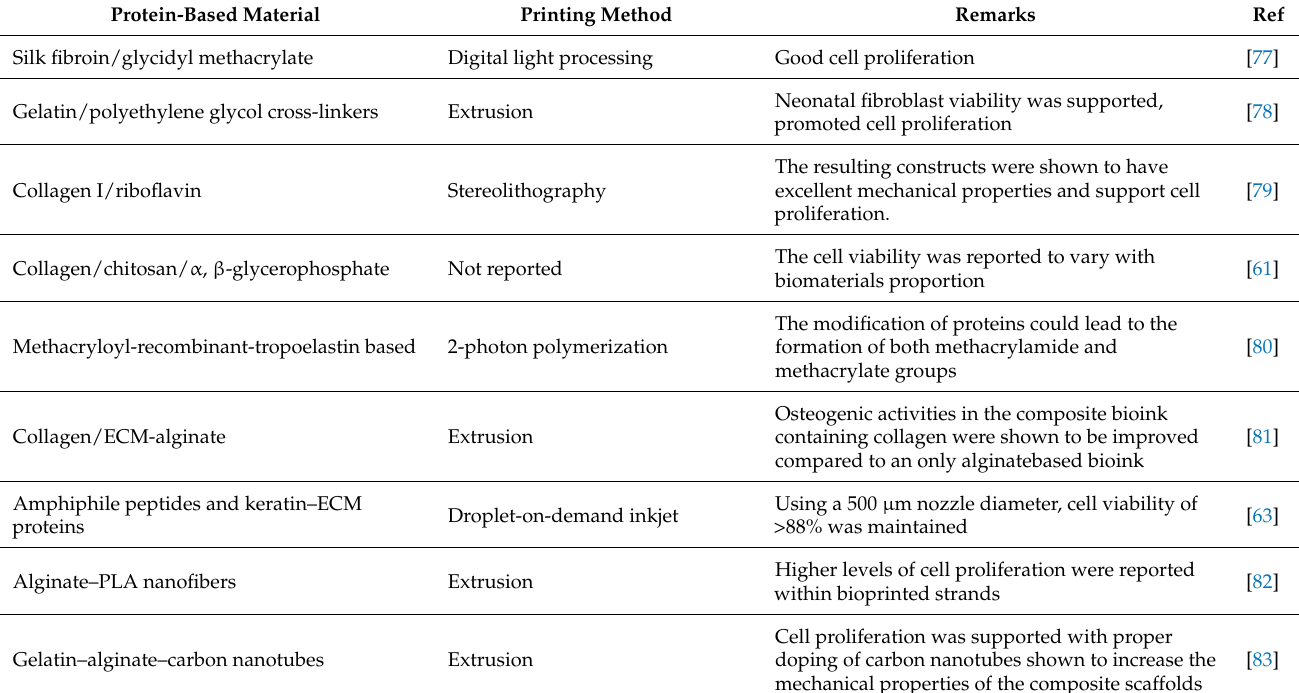
Table 3. Some protein-based materials that are employed in 3D